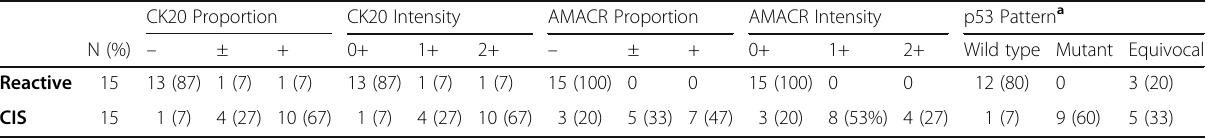
Table 1 CK20, AMACR, and p53 staining in Intradepartmental Consensus Urothelial Lesions